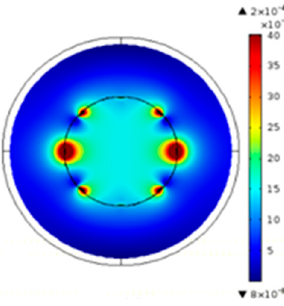
Figure 4. MRI RF magnetic field (vertically directed) distribution in the reference case: no material in the birdcage within the MRI tunnel [45].